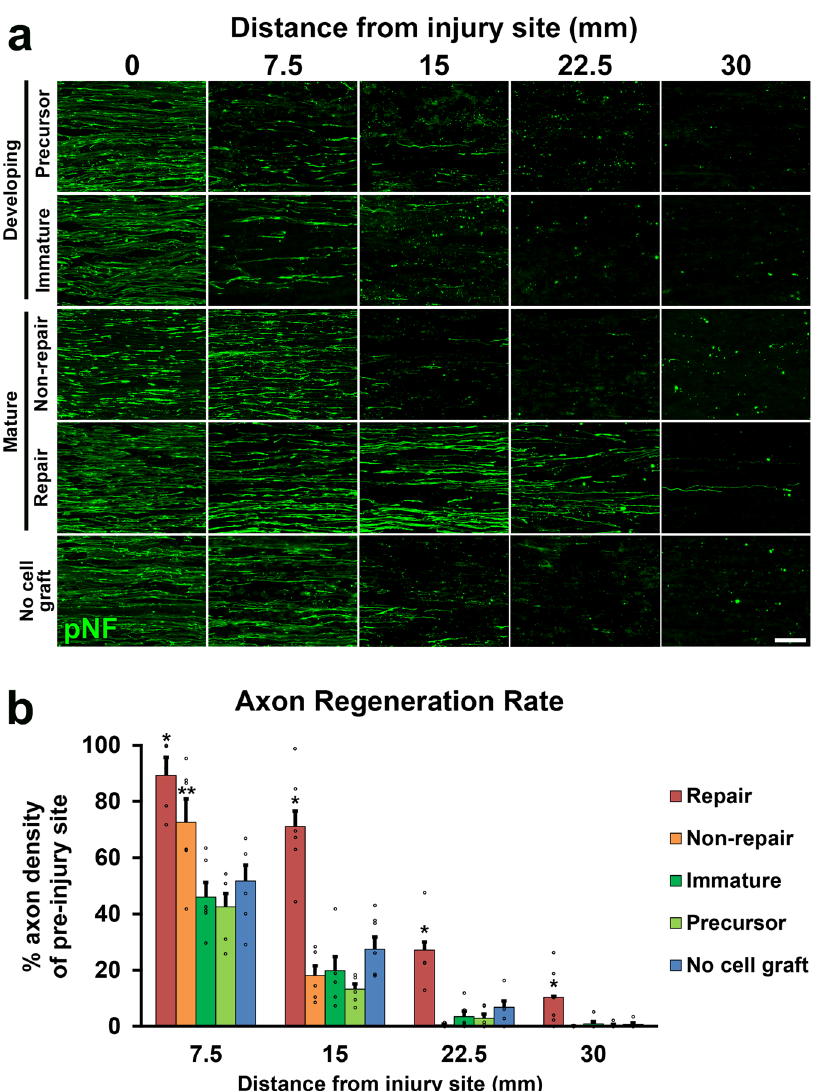
Fig. 3 Axon regeneration induced by grafted SCs. a Representative images of regenerating axons labeled by pNF in fi ve groups, which are graft of SCPs, ISCs, non-RSCs, RSCs, and no cell graft. RSCs grafts induced substantial axon regeneration. Left is proximal. Scale bar, 50 μ m. b Quanti fi cation of regenerating axons. RSCs grafts demonstrated the greatest axon-promoting effect among all groups. Non-RSCs grafts revealed statistically more axons than SCPs graft, ISPs graft, and no cell graft. Six rats per group. * P < 0.05 vs. others, ** P < 0.05 vs. ISCs, SCPs, and no cell graft, one-way ANOVA with the Tukey – Kramer test. Error bars represent the